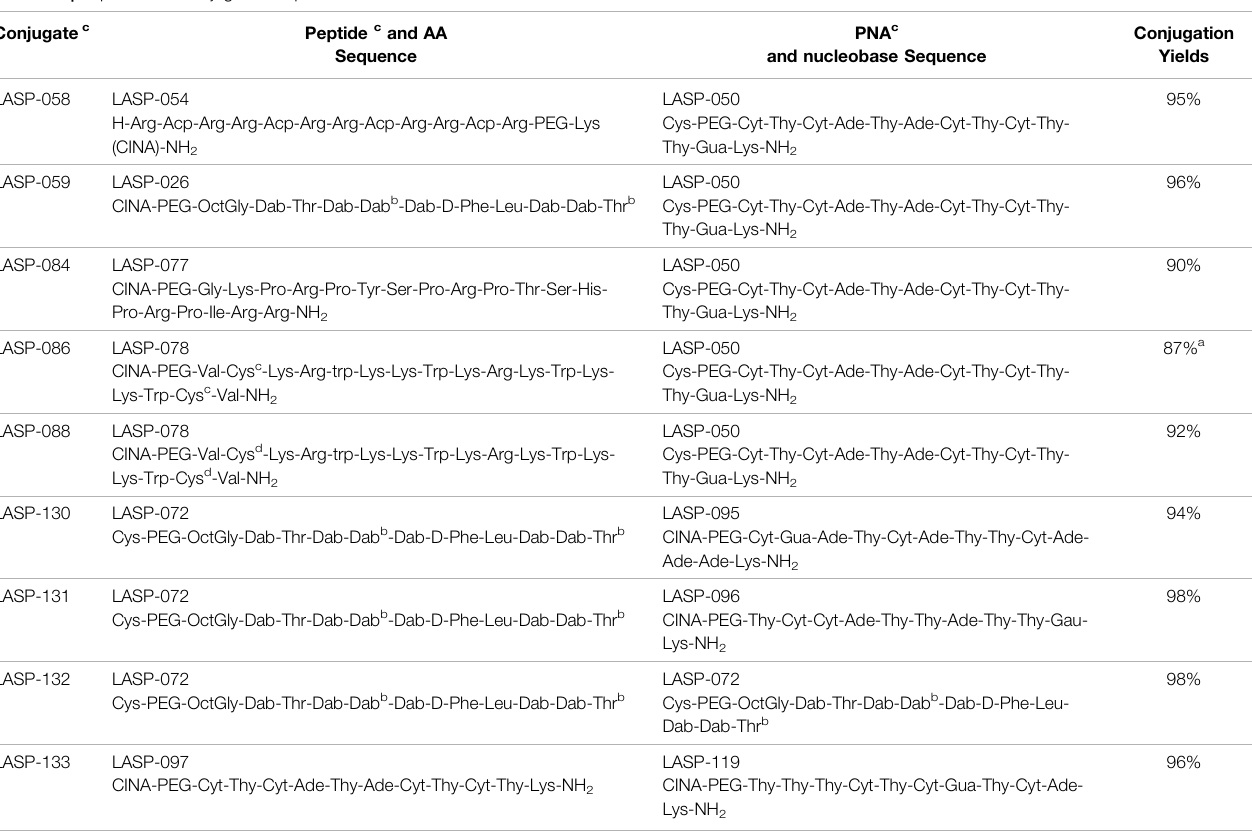
TABLE 1 | Peptide-PNA conjugates sequences. Conjugate c Peptide c and AA